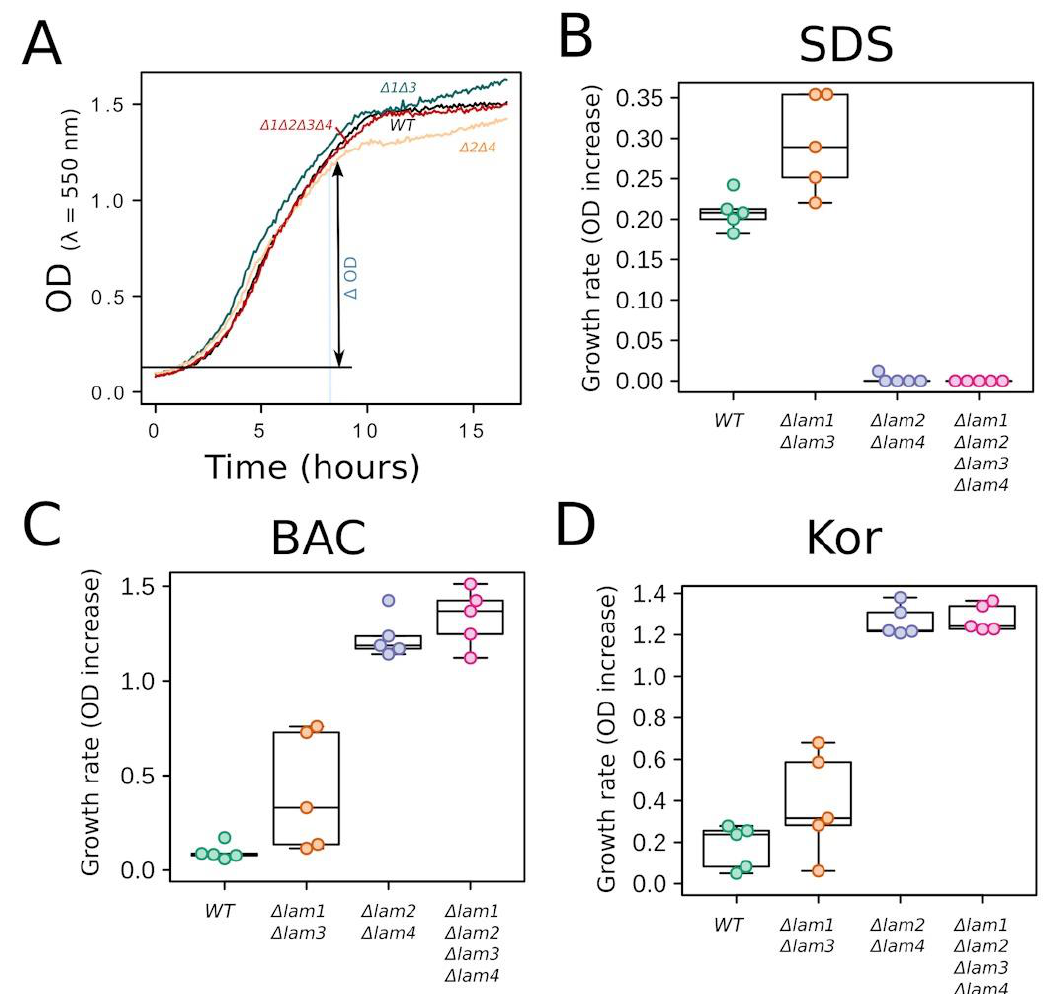
Figure 11. △ Lam2 △ Lam4 double-gene deletion decreases the resistance to SDS and increases the resistance to BAC and Kor105. ( A ) Representative growth curves of the wild-type and Lam deletion strains. ( B – D ) Growth rate of yeast mutants in the presence of negatively charged surfactant SDS, 0.01% ( B ) and positively charged surfactants BAC, 5 µg/mL ( C ) and Kor105, 2.5 µg/mL ( D ). To quantify the growth rates, we measured an increase in the yeast suspension optical density (OD) from 1 to 9 h of growth.